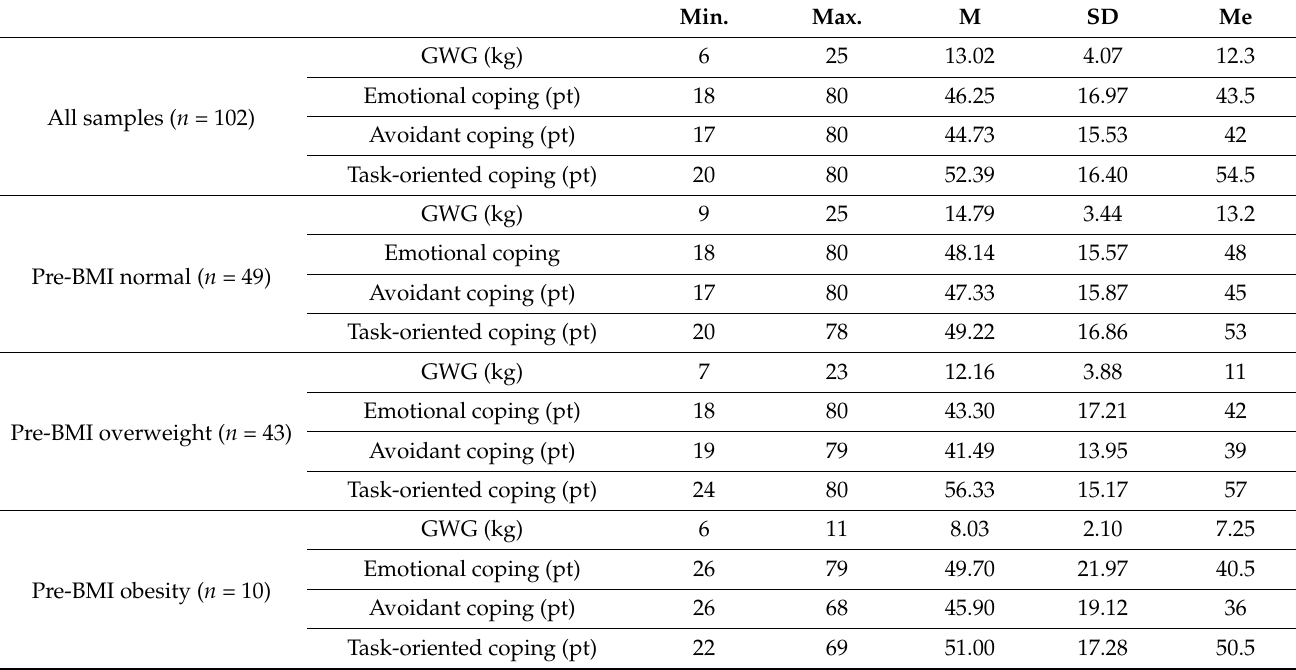
Table 2. Weight gain and styles of coping in the sample ( n =